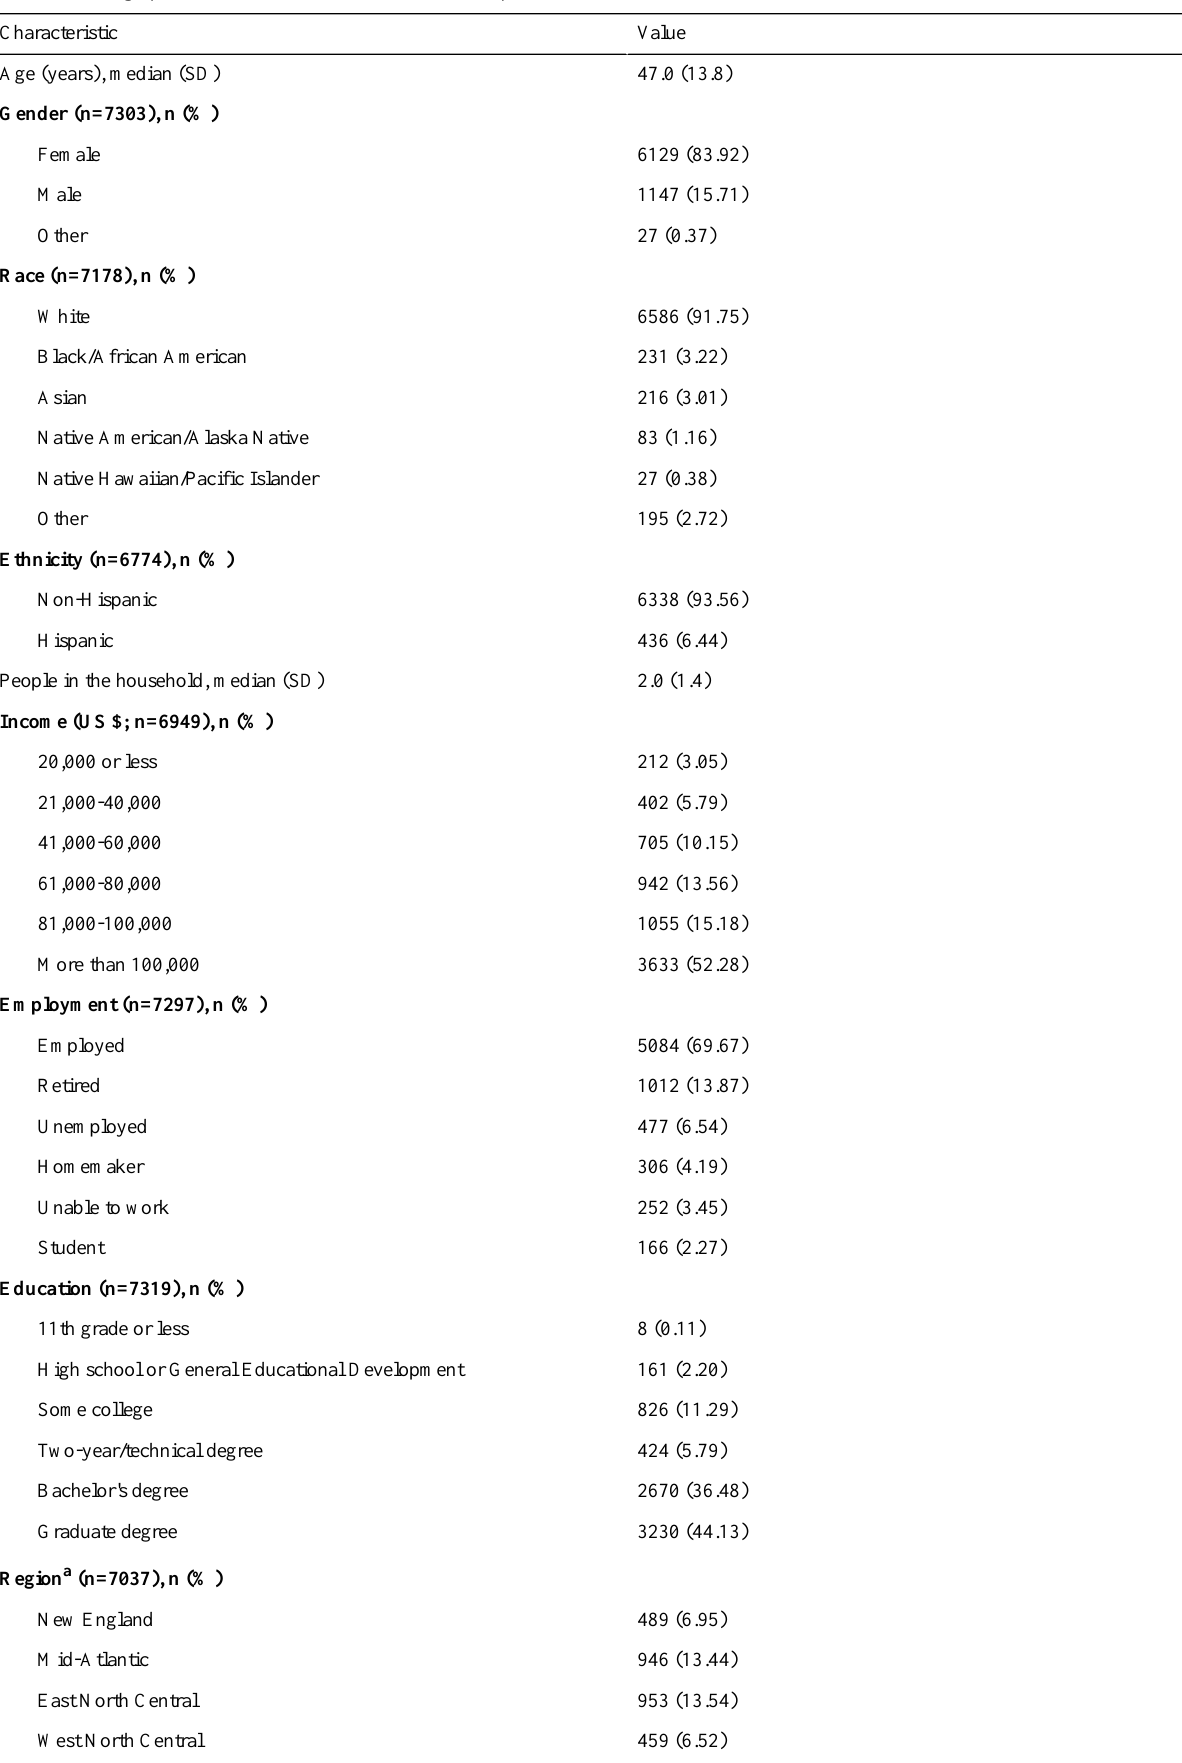
Table 1. Demographic and health characteristics of the sample